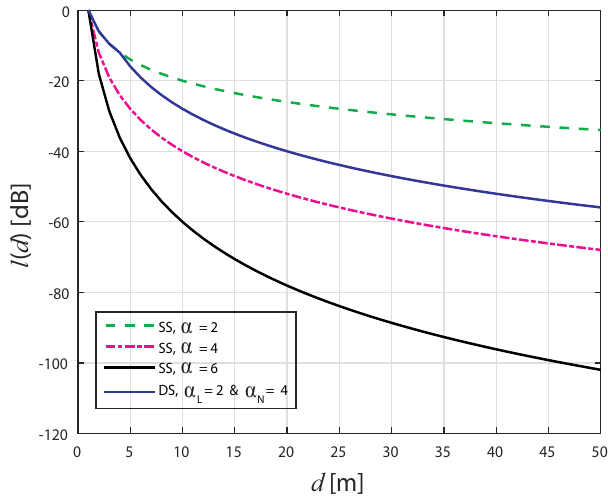
Figure 1. Comparison among three single-slope (SS) and one dual-slope (DS) for the path-loss exponents of 2 , 4 and 6